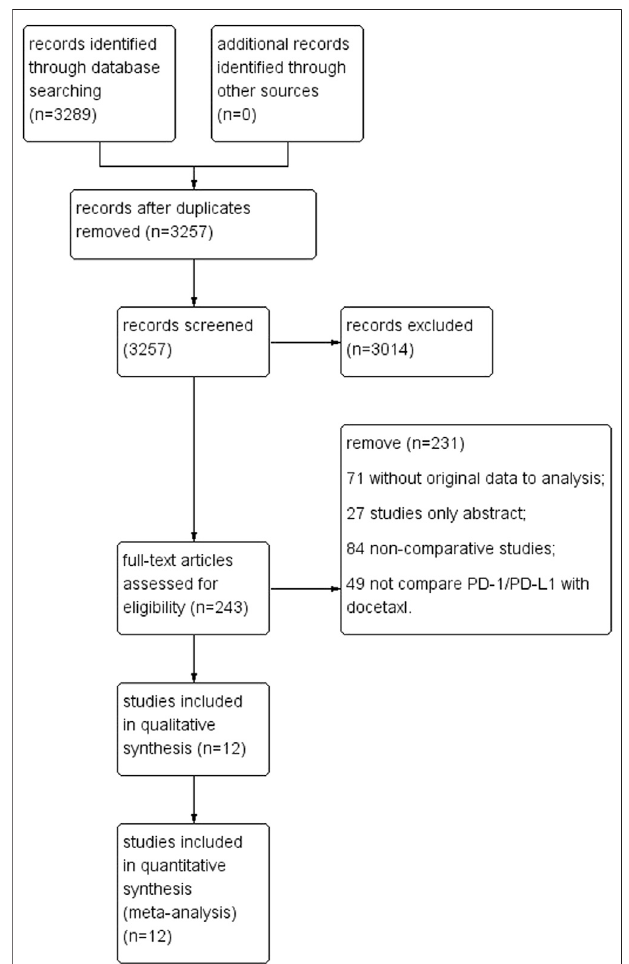
FIGURE 1 | Flow chart of study